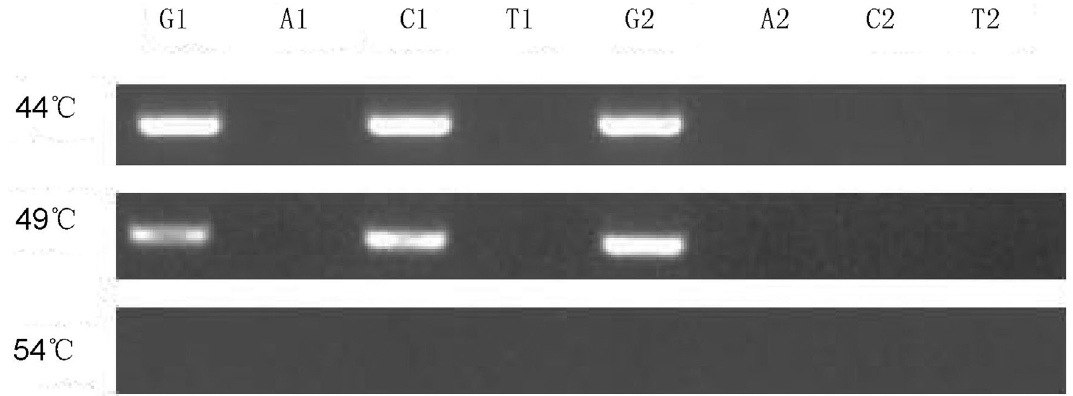
Figure 3 - Optimization of hybridization temperature. G, A, C and T represent the four reactions corresponding to each pair of detection probes.